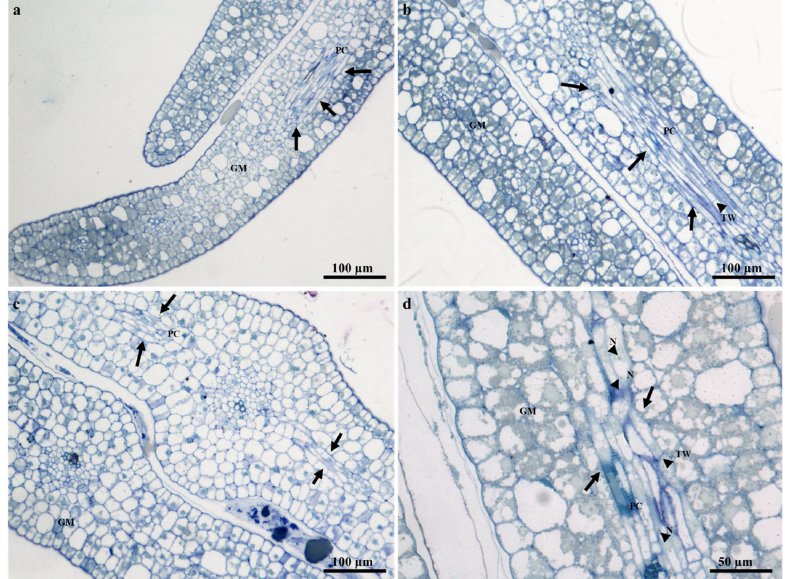
Figure 2. Light-micrographs showing the anatomy of laticifers in the mature embryos of T. ventricosa . ( a ) A longitudinal section through the mature embryo displaying the formation of articulated laticifers in cotyledons. ( b ) A longitudinal section through the mature embryo depicts the arrangement of articulated laticifers in the vascular region. Note the terminal walls within the cell. ( c ) A transverse section through the embryo displaying the occurrence of laticifers in the hypocotyl region. ( d ) A transverse section showing a highly magnified region of vascular tissue and laticifers in the hypocotyl area. Note the occurrence of terminal walls, and multinucleated laticifers Abbreviations: TW = terminal wall, N = nucleus, GM = ground meristem, PC = procambium. Arrows refer to laticifers.